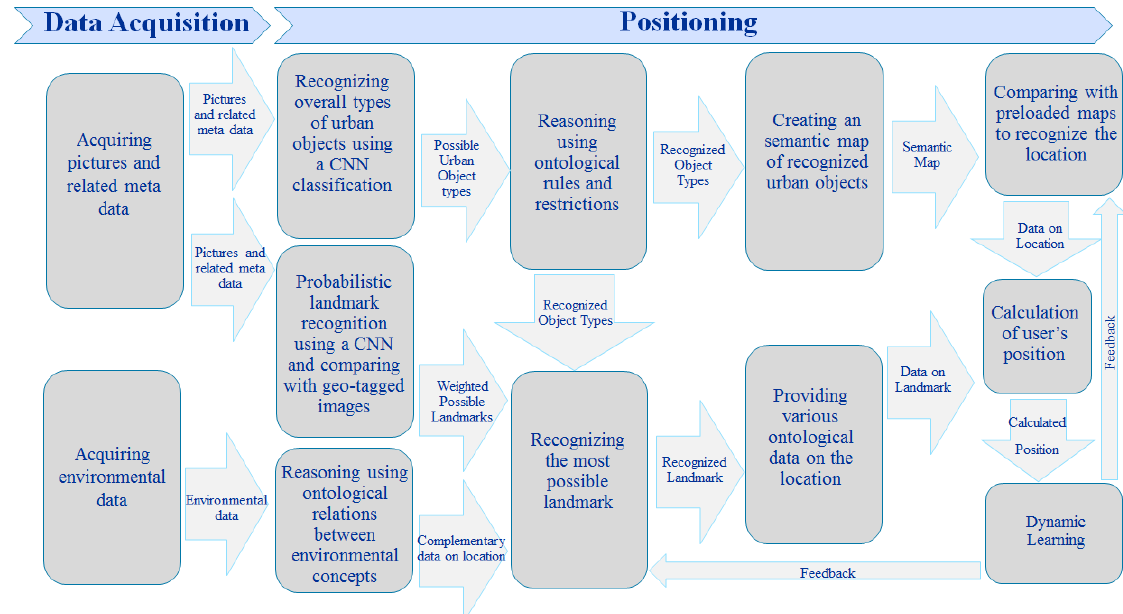
Figure 4 . Proposed conceptual framework for visual positioning using